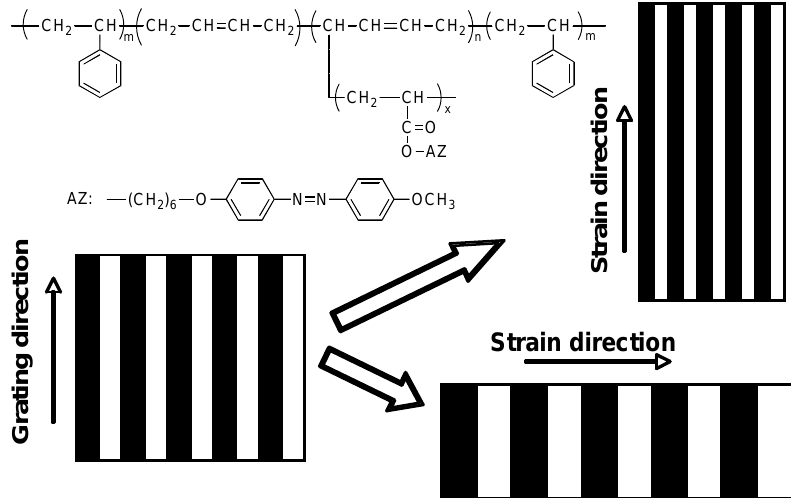
Figure 19. Mechanically tunable fringe spacing of gratings recorded in an ABA-type PRBC with